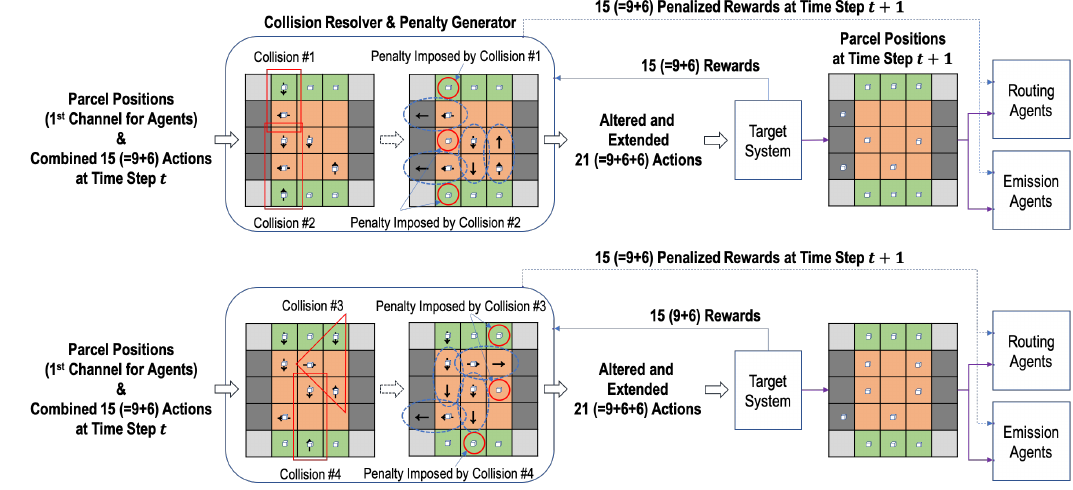
Figure 4. Diverse scenarios of collisions and their resolving in the three-grid sortation